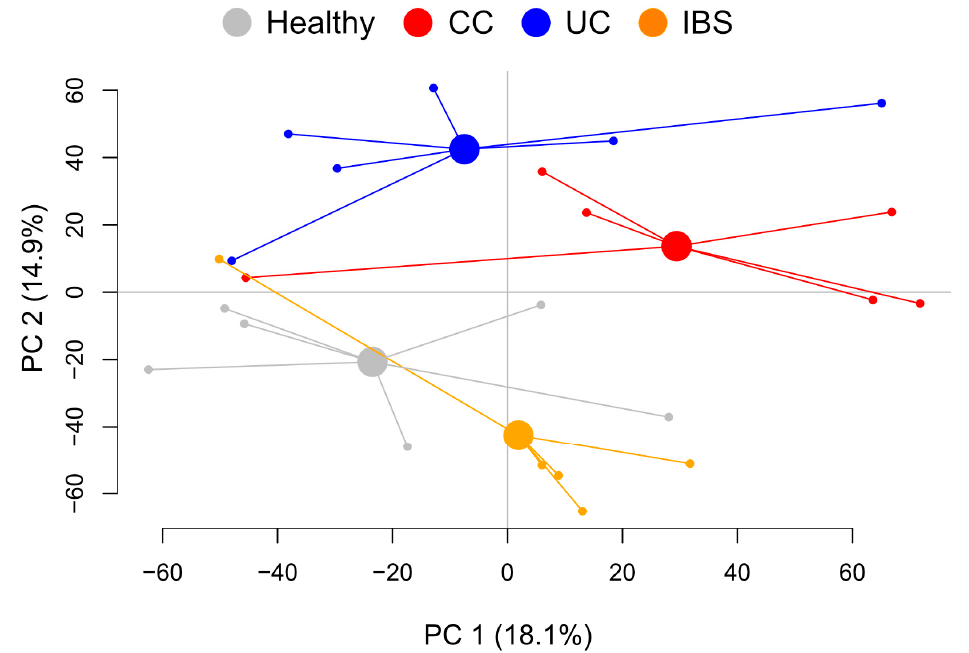
Figure 1. Metabolite profiles of fecal supernatants from healthy subjects and patients with colon cancer (CC), ulcerative colitis (UC) and irritable bowel syndrome (IBS). Fecal supernatants were analyzed by untargeted LC/MS. Results for the detected 9,699 spectral features of the fecal supernatants are shown for principal component analysis (PCA). n = 6 in each group. CC, colon cancer; UC, ulcerative colitis; IBS, irritable bowel syndrome; PC, principal component.